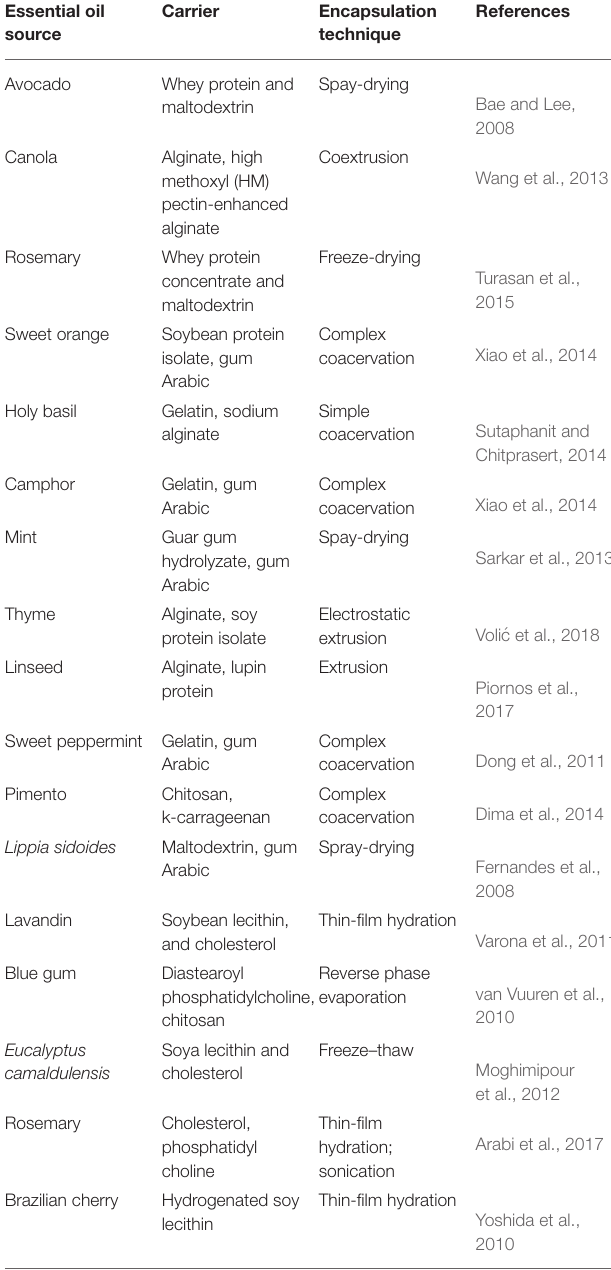
TABLE 3 | Examples for mixed carriers and encapsulation techniques for essential